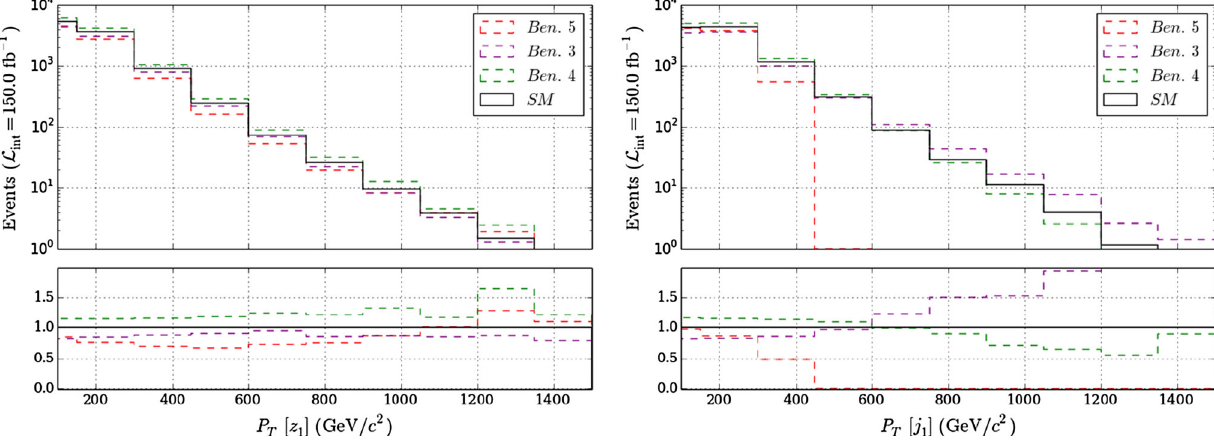
Fig. 8 Example of a benchmark scenario (B5 in Table 2) that is realistic in terms of cross section and p T ( Z ) , but has non-physical kinematics in the p T ( j )